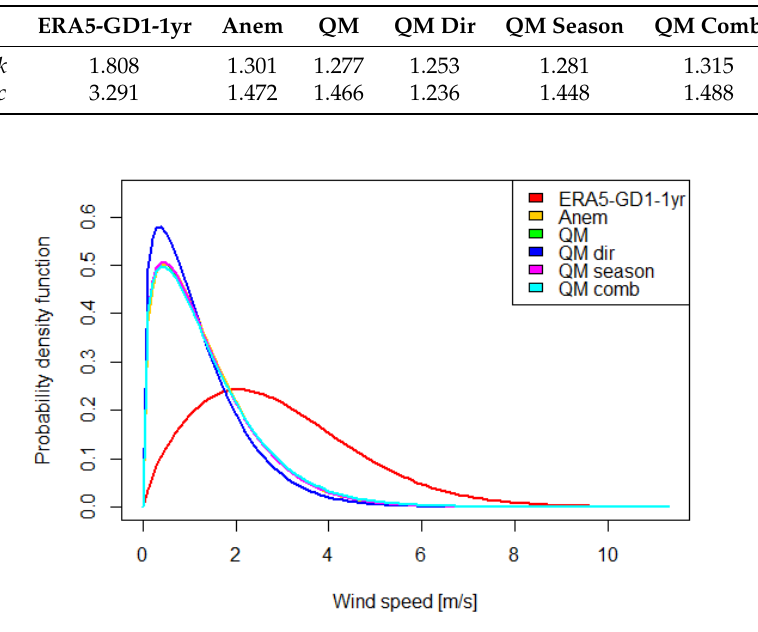
Figure 15. Probability density functions of the Weibull distributions of various wind speed series covering a 1-year